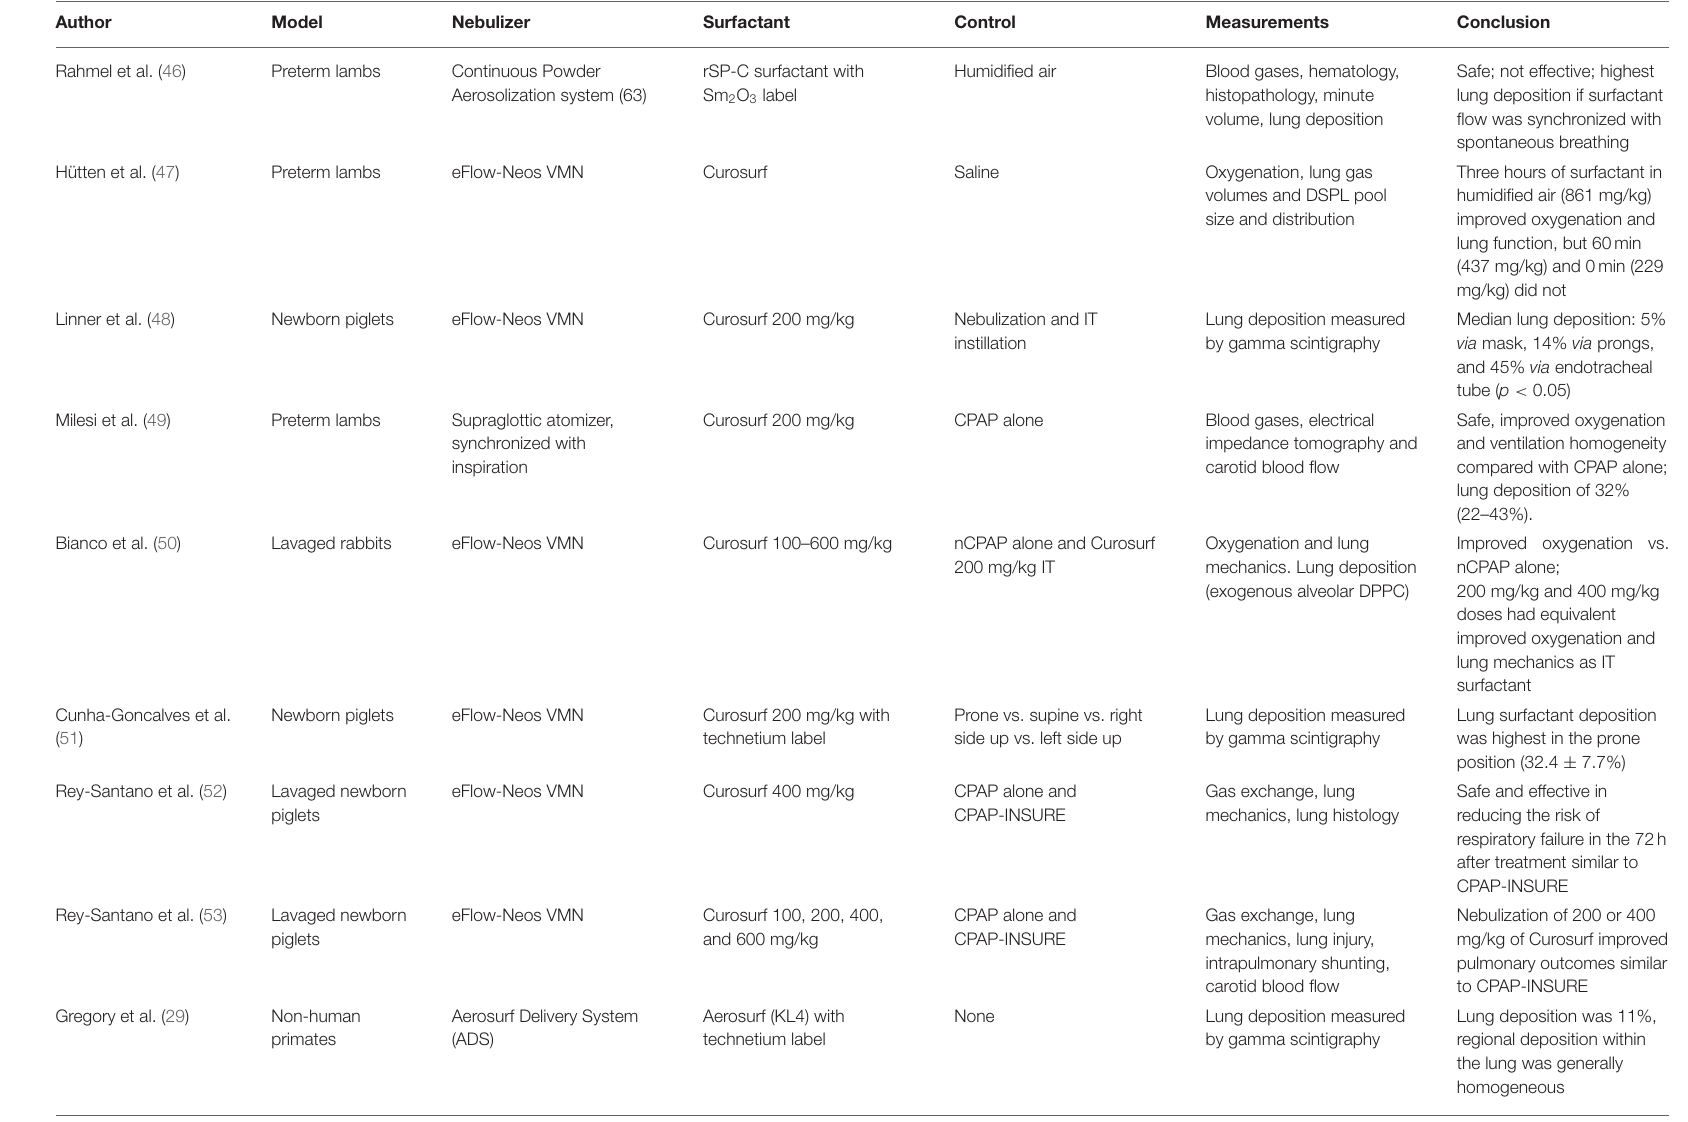
TABLE 1 | Summary of aerosolized surfactants and nebulizers utilized in studies in animals supported with nasal CPAP (nCPAP)